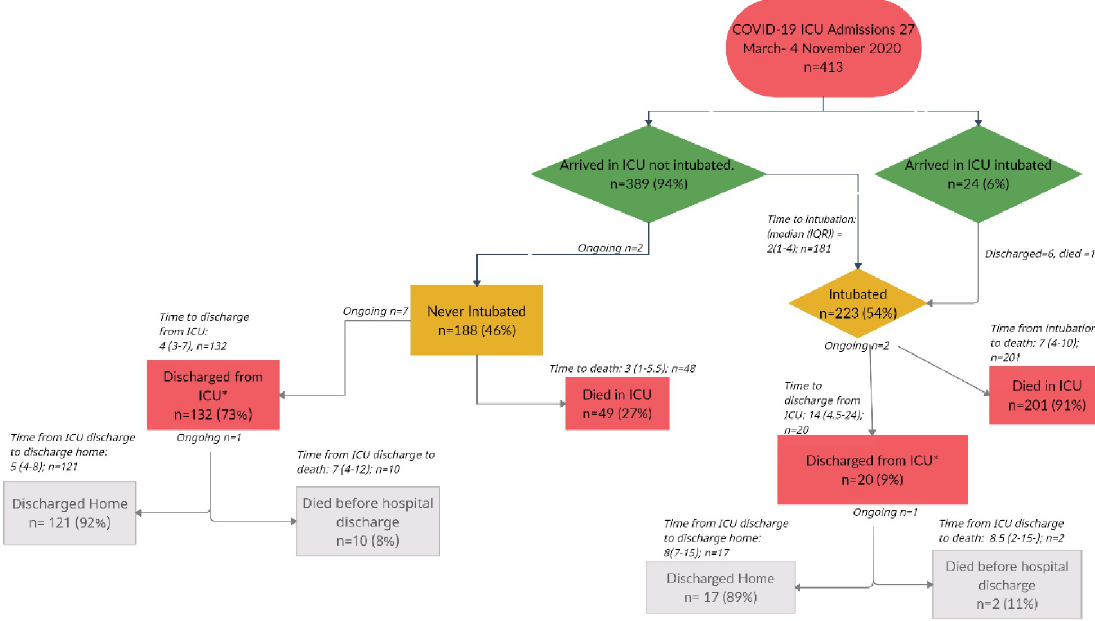
Fig 1. Distribution and outcome of COVID-19 patients admitted in the